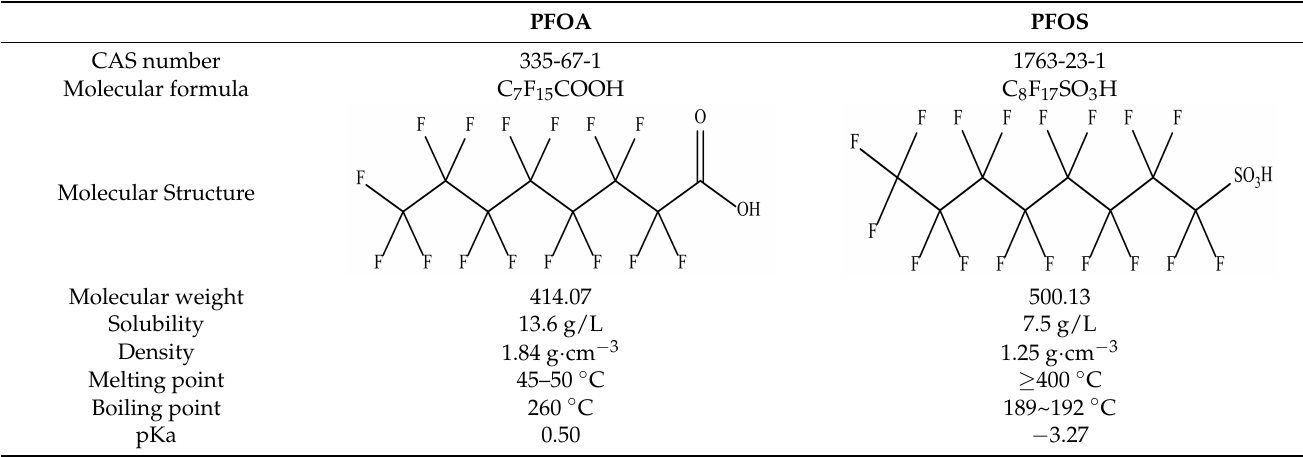
Table 1. The basic chemical and physical properties of PFOA and PFOS.